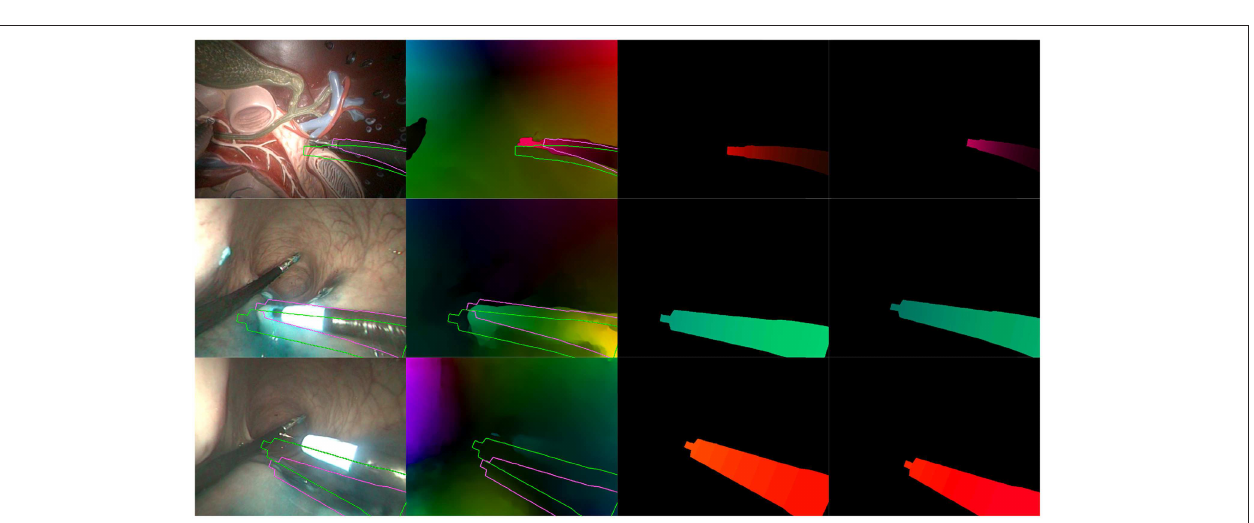
FIGURE 9 | Examples of incorrect results obtained with our optimization algorithm. (Top) Incorrect extraction of the instrument tip. (Middle) Bad convergence due to a badly estimated ˆ F . (Bottom) Incorrect estimation due to hand-eye calibration errors. Columns are the same as in Figure 8